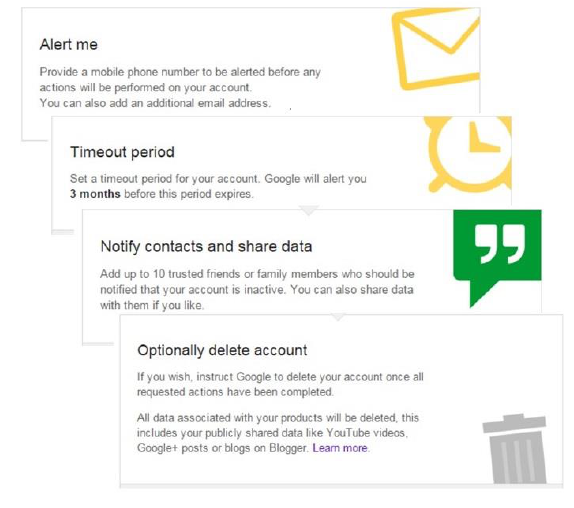
Fig. 4 - Representation of decision space in Google